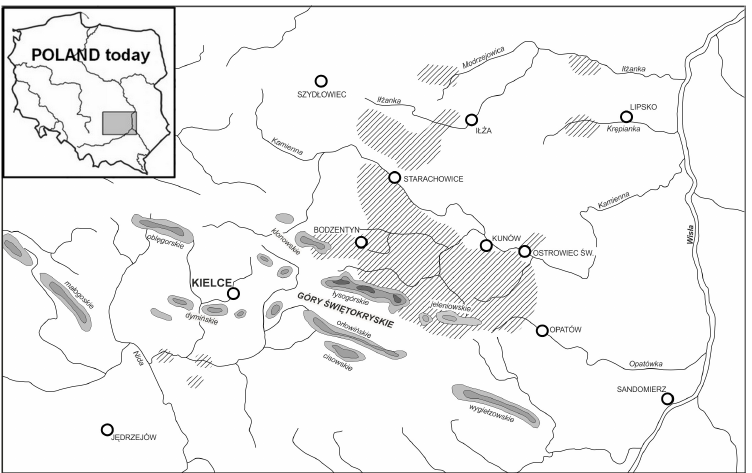
Figure 3. The range of densely occurring slag sites in the ´Swi˛etokrzyskie Mountains and its potential exclaves. In the north are the basins of the Ił˙zanka, the Kr˛epianka, and the Modrzejowica rivers. In the south is the basin of the lower and middle Nida river. Reproduced with permission from Orzechowski S., Region ˙zelaza. Centra hutnicze kultury przeworskiej published by Wydawnictwo Uniwersytetu Jana Kochanowskiego, 2013